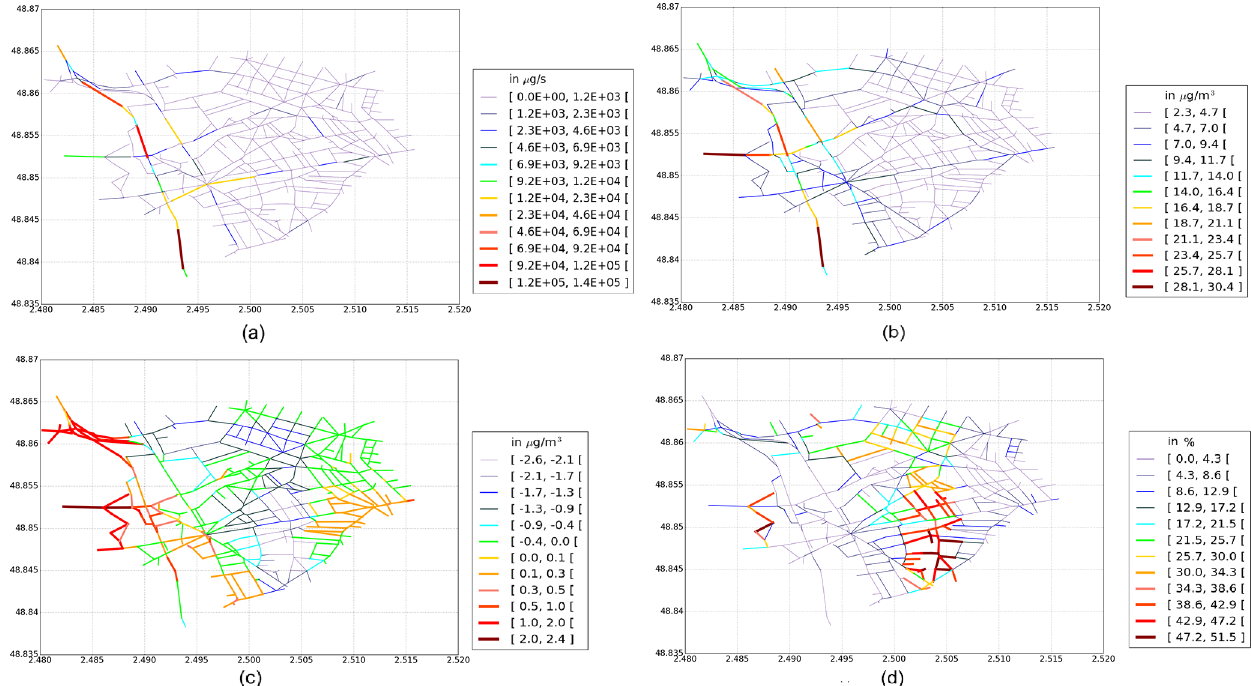
Figure 6. Average BC emissions in the street network (a) , average BC concentrations simulated by SinG (b) , absolute differences between the BC concentrations simulated by SinG and MUNICH (c) , and absolute values of relative differences between the BC concentrations simulated by SinG and MUNICH (d) .